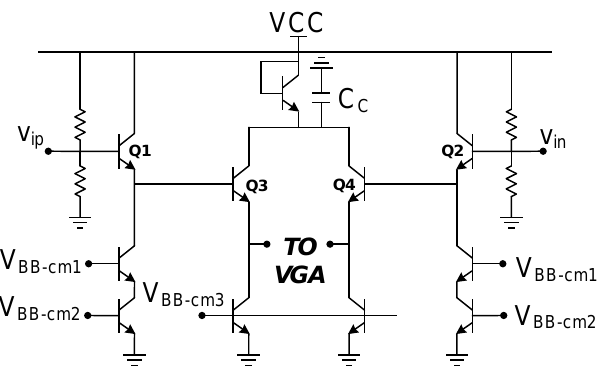
Figure 5. Schematic of the cascaded emitter followers used as an inter-stage buffer. The same stage is also used as an output buffer for the complete